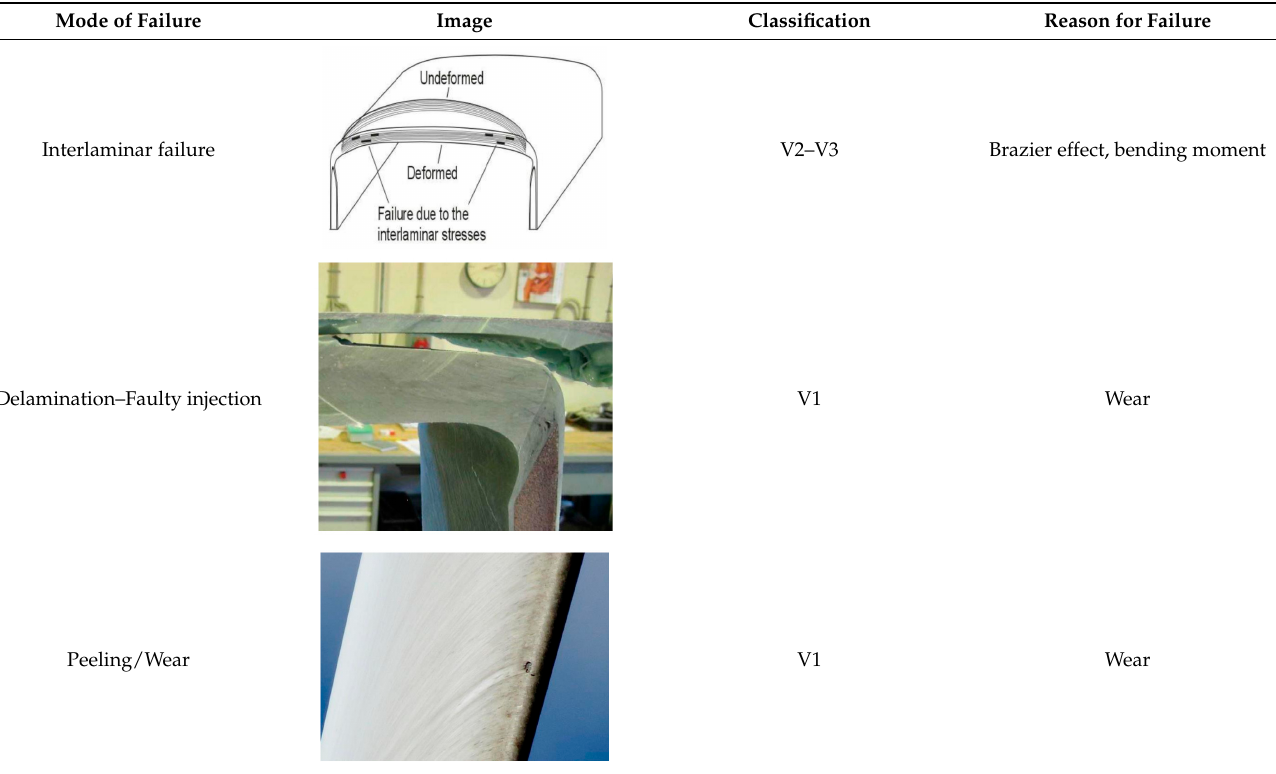
Figure 16. Damages in the aeroshell and box girder; sketches of found failure modes in a wind turbine blade purposefully tested to failure [161]. Table 1. Failure modes of wind turbine blades [163].